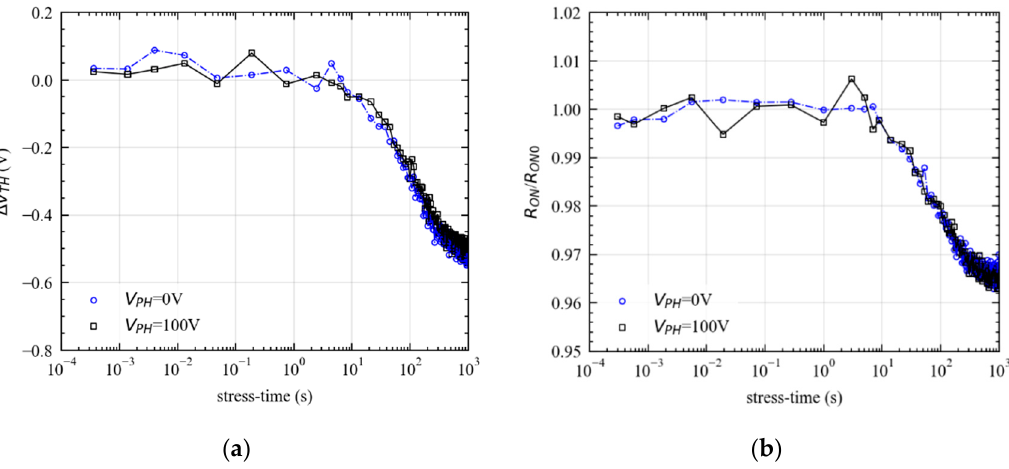
Figure 9. Comparison between ( a ) V TH and ( b ) R ON drift obtained with V PH = 0 V and V PH = 100 V.